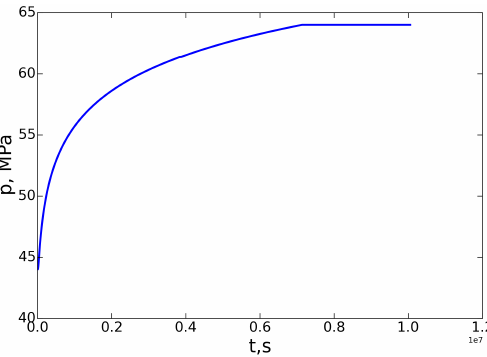
Figure 3. Pore pressure change at the boundary between the first block and substrate.